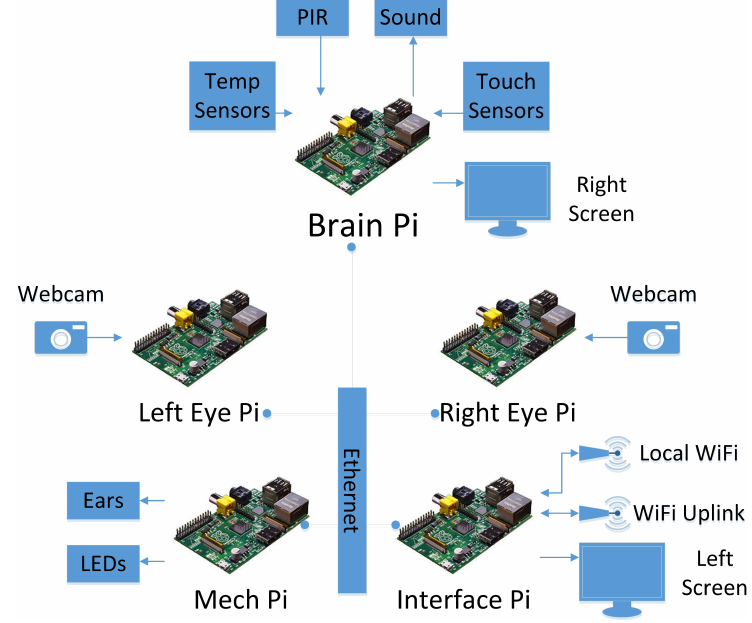
Figure 3. Erica’s Pi architecture as initially